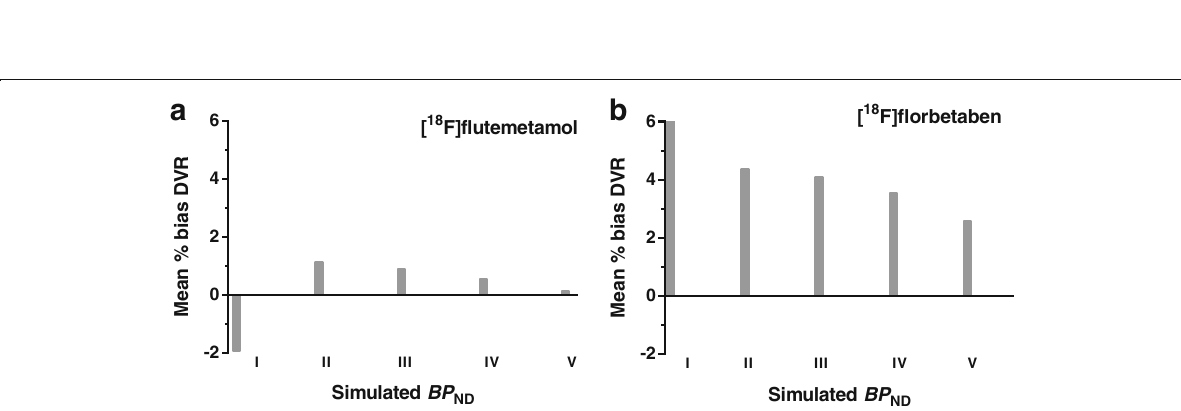
Fig. 4 Percentage bias in SRTM-derived DVR of 2T4k_V b -generated TACs. a Bias in DVR for [ 18 F]flutemetamol. b Bias in DVR for [ 18